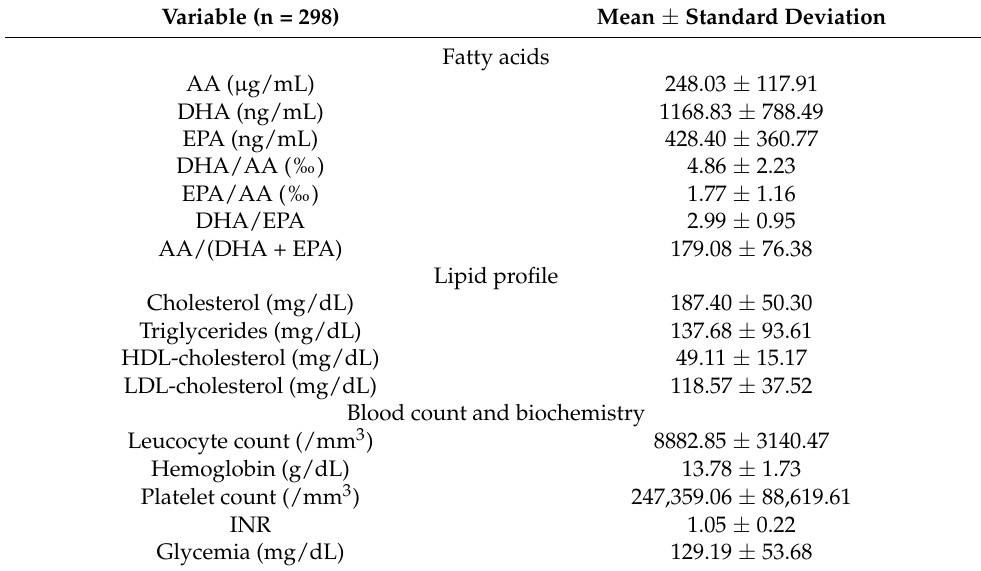
Table 2. Paraclinical